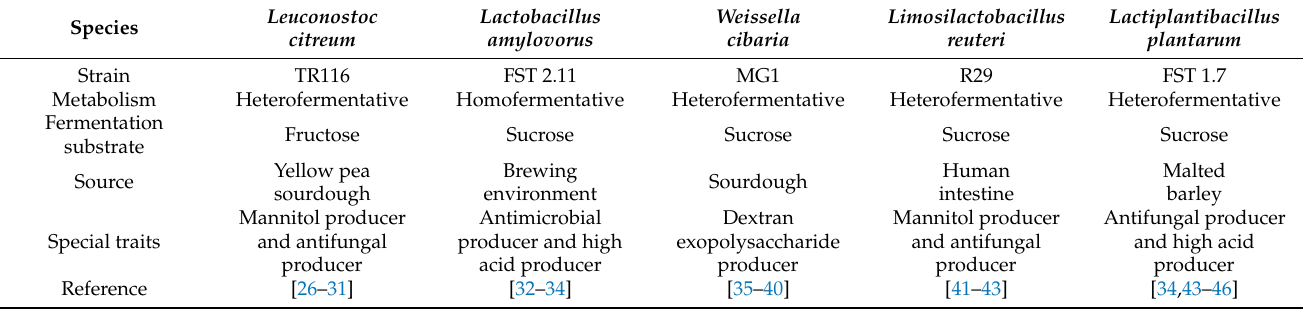
Table 1. Characteristics of lactic acid bacteria incorporated in barley rootlet ingredient development.